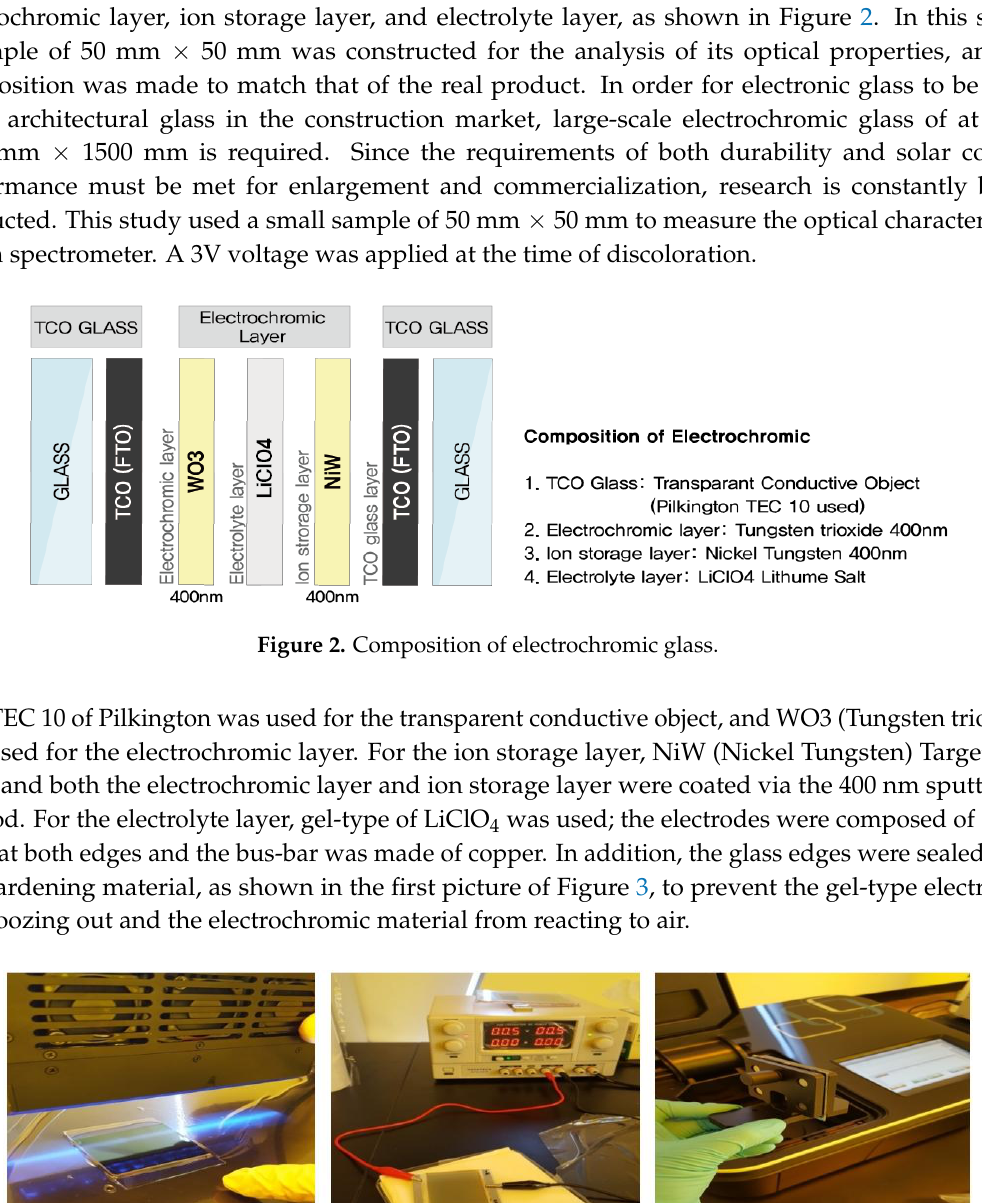
Figure 3. Producing, voltage permission, and spectrum analysis experiment process of the electrochromic glass.